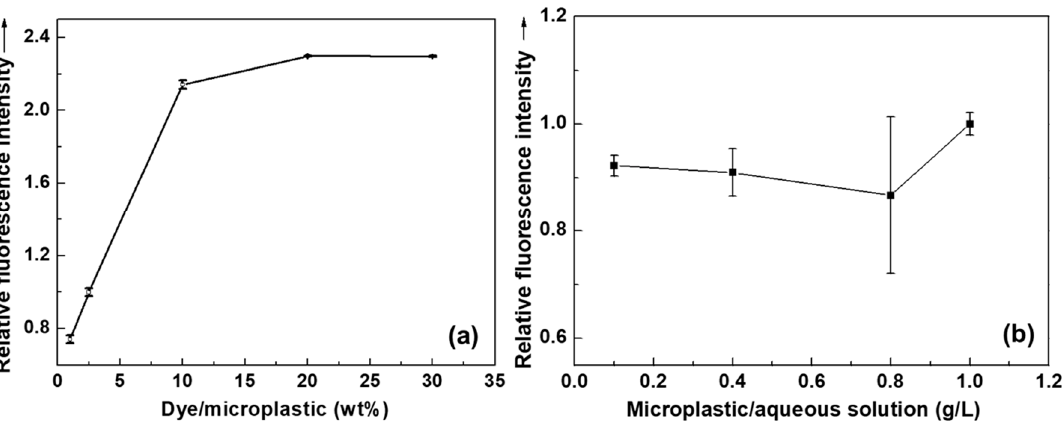
Figure 7. Relative fluorescence intensity of PP MPs stained with different dye/MP ( a ) and MP/aqueous solution ( b ) ratios. Staining conditions: dye = S-FN; surfactant = Tween 20; dye/surfactant = 1 g/L; staining time = 60 min; staining temperature = 80 °C. MP/aqueous solution is 1 g/L for ( a ), and dye/MP is 2.5 wt% for ( b ).